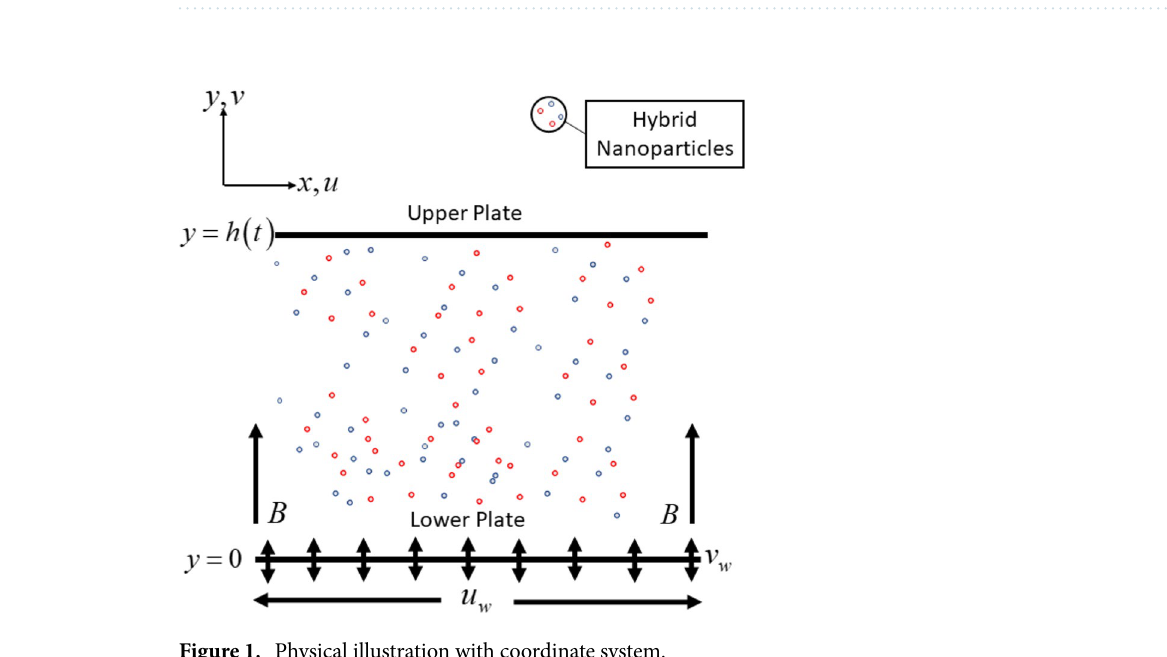
Table 1. Detail description of references concerning the internal flow between two plates.